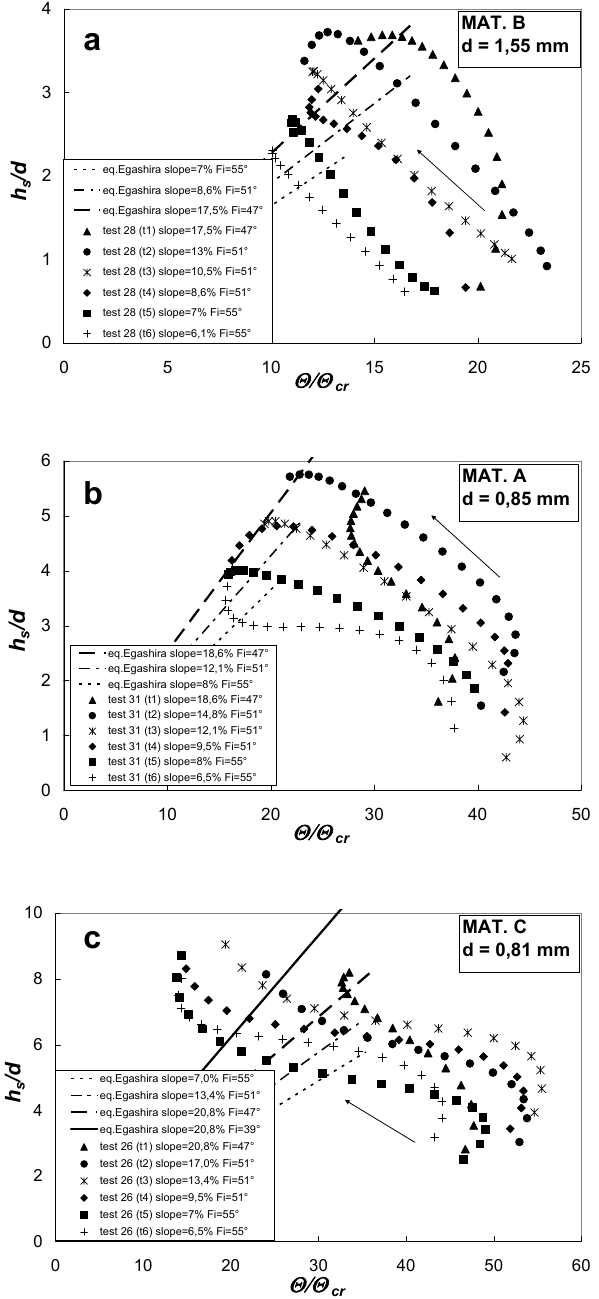
Fig. 14. Comparison between measures of moving layer relative depth ( h s /d ) vs. 2/2 c and Egashira (1992) equilibrium curves. Since Egashira equation does not show significant variations with slope (for fixed 2/2 c (s j ,t i ) ), it is shown here, for simplicity only, three reference equilibrium curves, computed for the friction an- gles involved ( 8 =47 ◦ ,51 ◦ , 55 ◦ ) and for three representative slopes. From experimental data, it seems that equilibrium is reached but lost again around the last embankment sections: in (c) h s /d values are even over Egashira equation computed with the minimum friction angle (39 ◦ ).